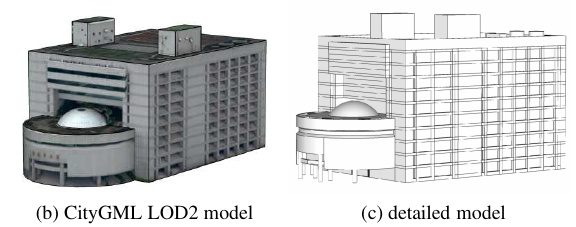
Figure 4: 3D reconstruction of a building with non-planar struc- tures from a single image.